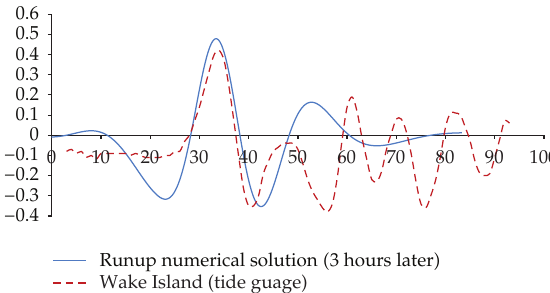
Figure 6: Wake Island: Data showing tsunami about 125 minutes after the earthquake and run-up model for Wake Island